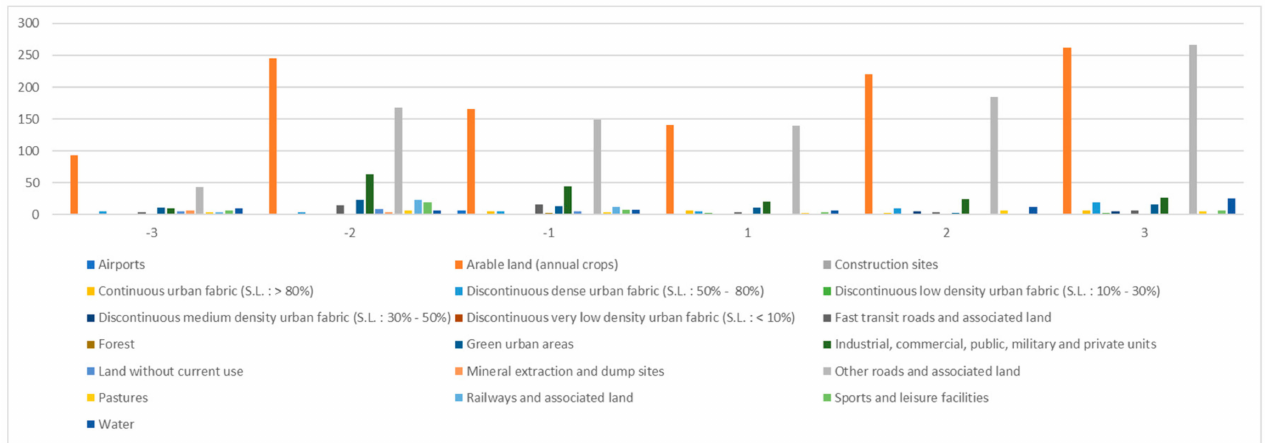
Figure 16. Quantity comparison of the land-use dataset contained by the hot/cold spots